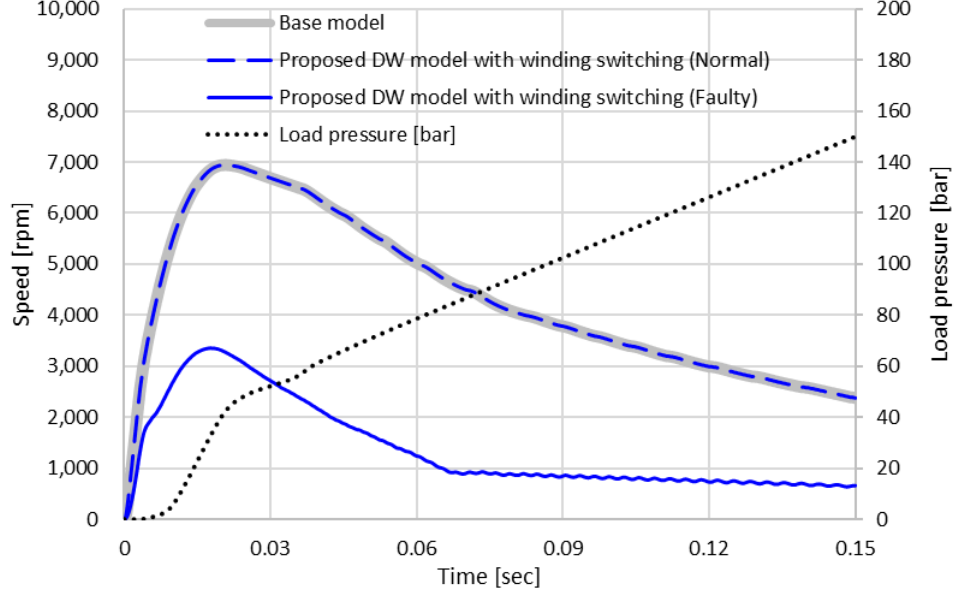
Figure 17. Comparisons of speed response characteristics between the base model and the proposed DWM with WS.